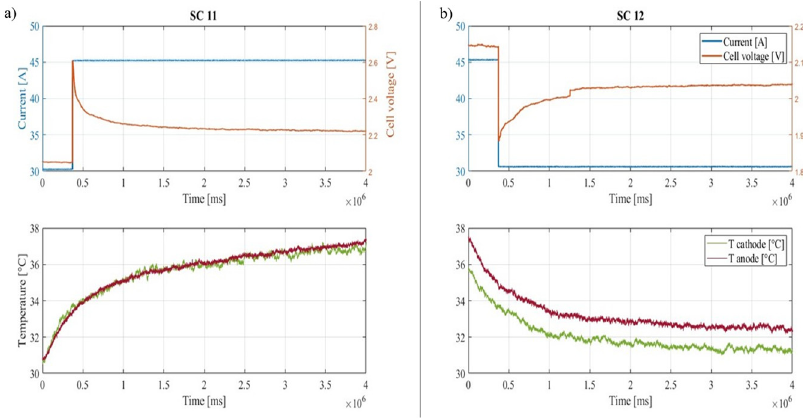
Figure 11. Obtained experimental results: ( a ) SC11 (30–45 A), and ( b ) SC12 (45–30 A).